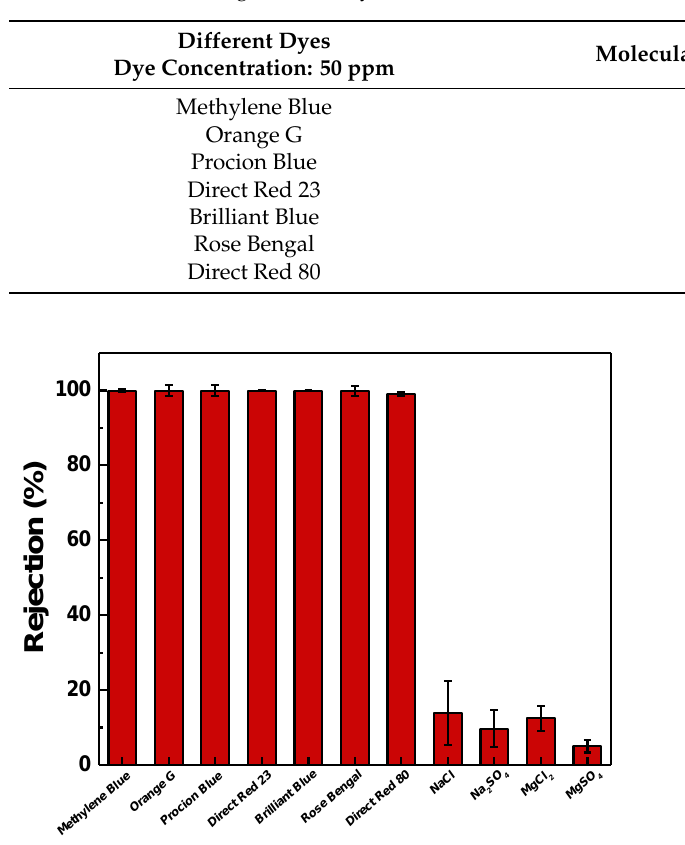
Figure 9. PES Ag-PDA0.3 performance on different dye and salt solution. Feed = 50 ppm of Dye; Operating pressure 4 bar; Operating temperature = 30 °C.